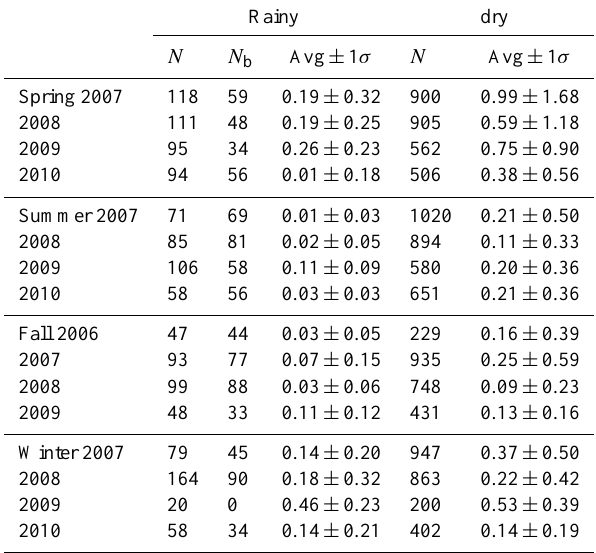
Table 1. Seasonal mean (denoted as avg) ± 1 σ values (ppqv) of RGM at Thompson Farm for rainy and dry conditions. N stands for the number of samples. N b stands for the number of samples with RGM below the